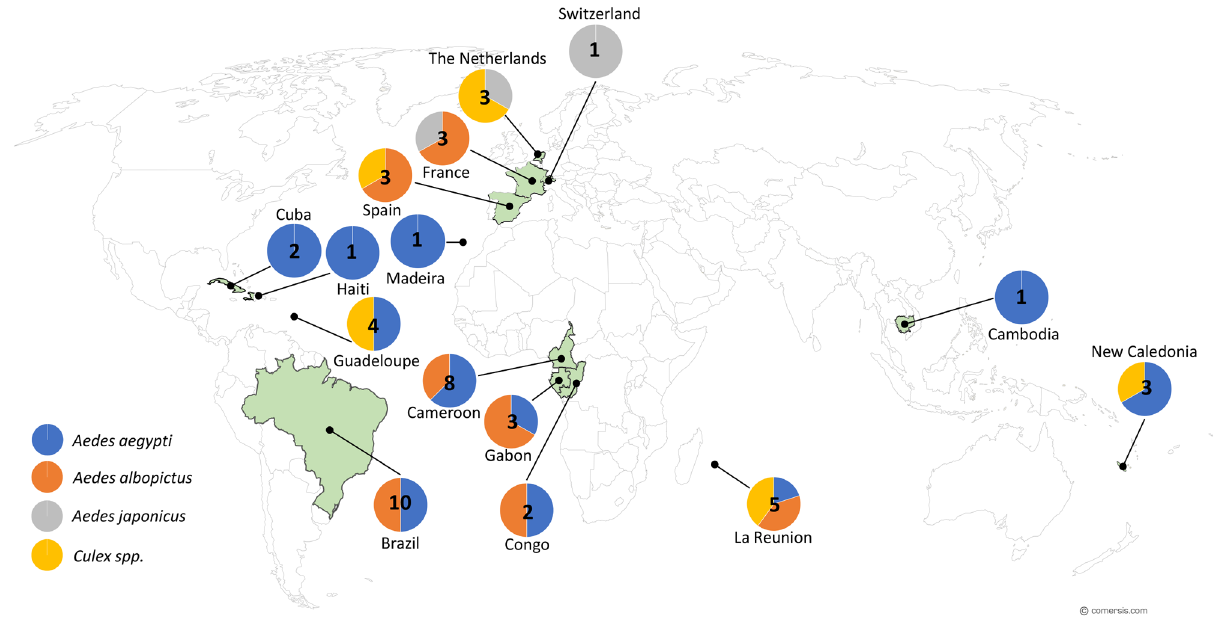
Fig. 4 | Distribution of mosquito species experimentally infected with Zika viruses. The color code used represents the different mosquito species and numbers refer to the number of mosquito populations tested. In green, are the